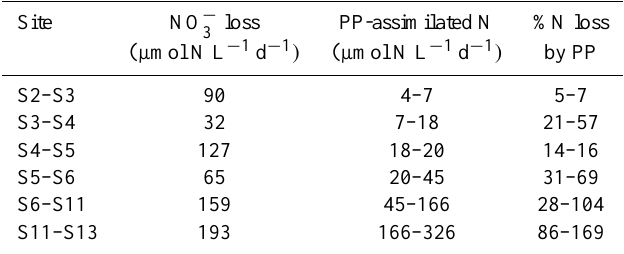
Table 1. Inter-site comparison of average NO − loss and pelagic 3 primary production (PP)-assimilated N in order to delineate the pri- mary control of NO − loss for sites S2 to S13 during the dry sea- 3 son. The calculation of average NO − loss is outlined in the discus- 3 sion section. The range for PP-assimilated N is calculated using the upstream and downstream pelagic PP observations and converted from C uptake to N uptake using the Redfield C:N ratio. It must be stressed that these are basic calculations with a number of assump- tions (see